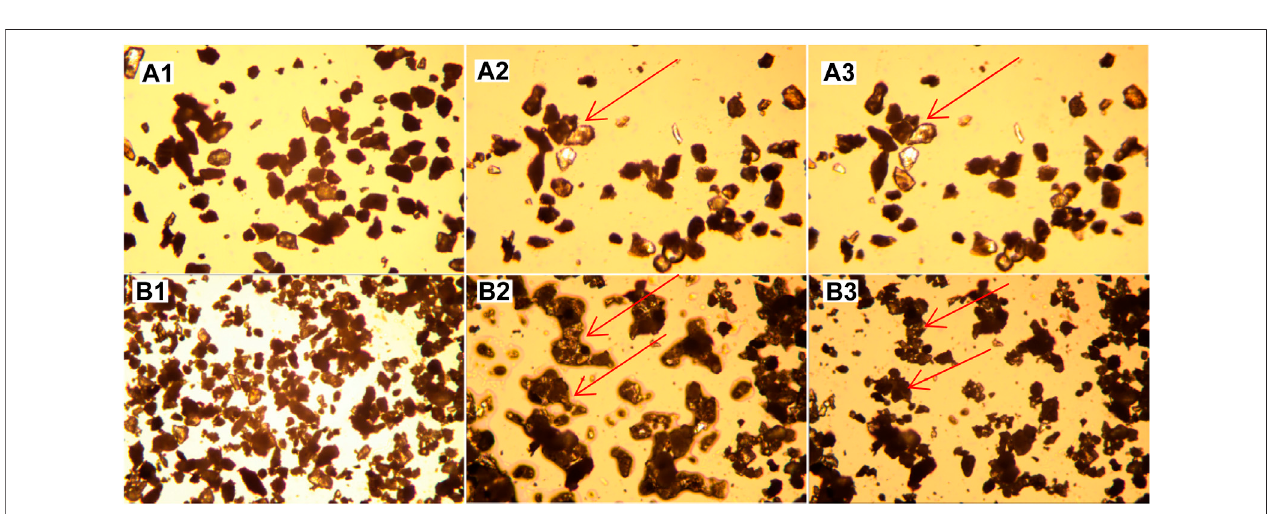
Figure 10A1 and Figure 11B1 show the original images right before the droplet contacted the dust. contact, in Figure 11A3 , after 5 ms, municipal water droplets stir particles adhered to the surface of the droplet. In Figure 11A4 , particles scattered around the droplet irregularity. Finally, in Figure 11A5 , the droplets stay in a stable shape, which indicates Figure 11B3 , no dust particles were stirred up by the